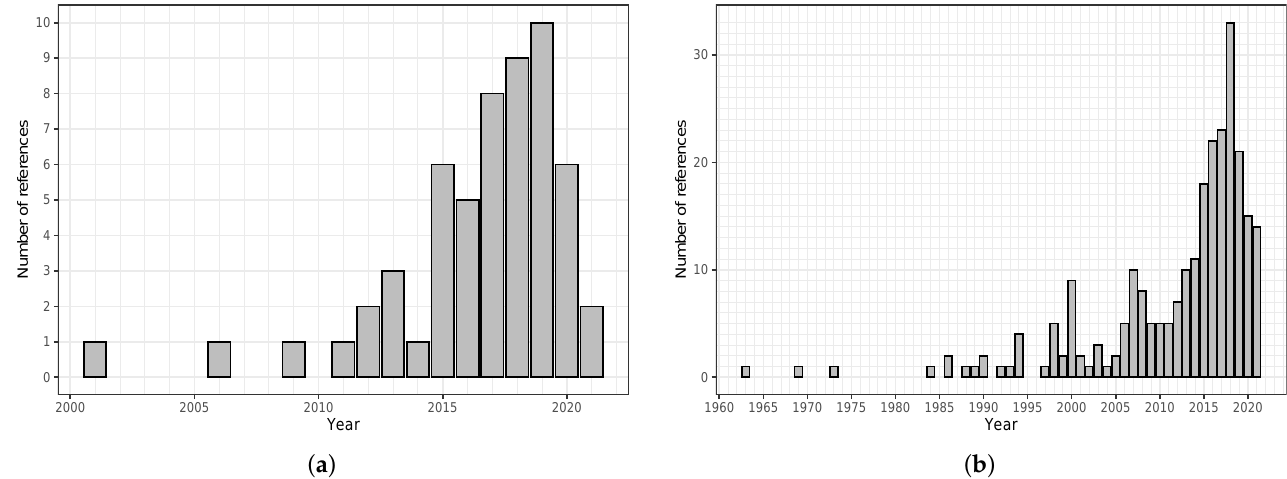
Figure A1. Graph ( a ) is the histogram of the number of references vs. year for the 56 initial references on driver monitoring (DM), and graph ( b ) is the corresponding histogram for the 254 examined references. These histograms suggest that the field of DM has been the object of growing interest over the years and, in particular, over the last 10